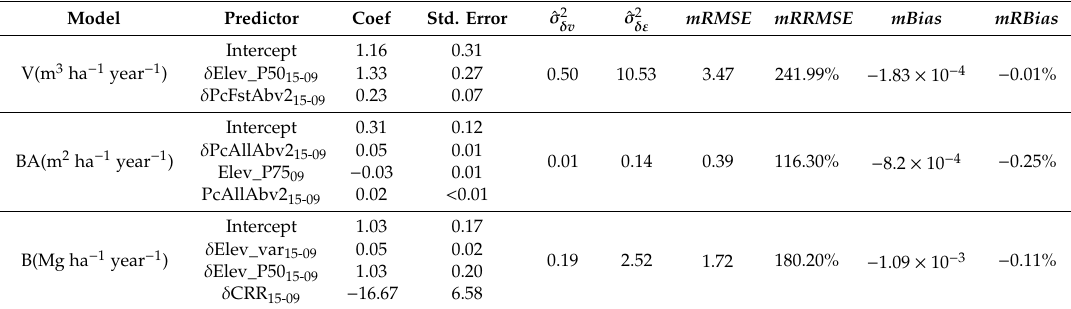
Table 2. Summary models for the δ -modeling method. Model coe ffi cients, standard errors of the model coe ffi cients, variance parameters and general metrics for accuracy assessment are provided. Predictor acronyms are explained in Table A1. Coef is the value of the coe ffi cient and Std.Error its corresponding standard error. V indicates volume, BA indicates basal area and B indicates